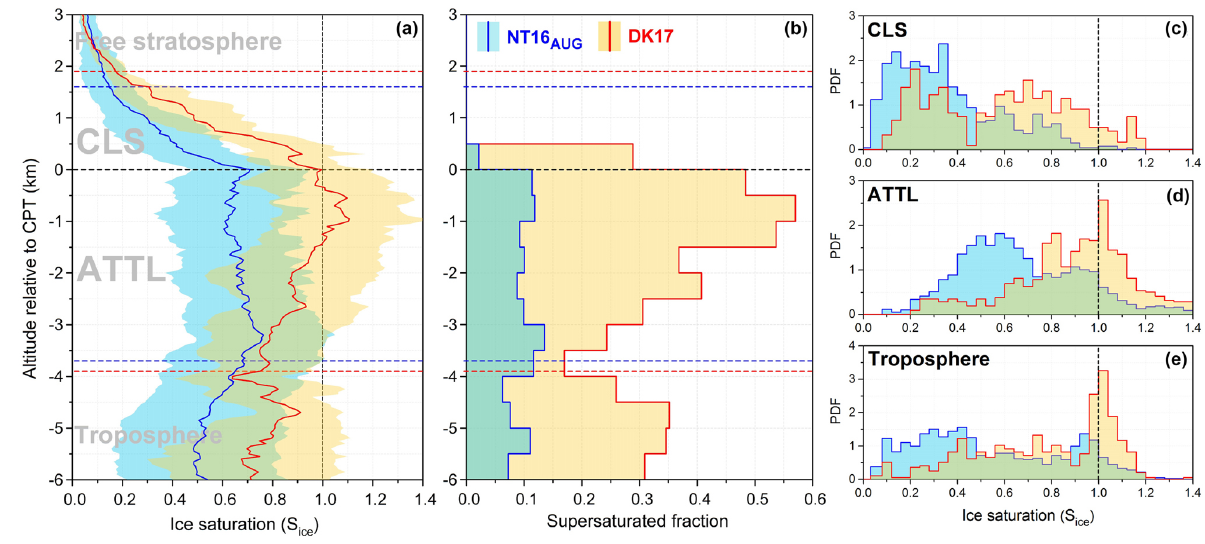
Figure 9. (a) Mean profiles and standard deviation of ice saturation ( S ice ) as a function of altitude relative to the CPT, for NT16 AUG (blue) and DK17 (red). (b) The supersaturated fraction (i.e., fraction of measurements with S ice >1) as a function of altitude relative to the CPT. (c, d, e) PDFs of ice saturation in the CLS, ATTL and troposphere altitude regions,